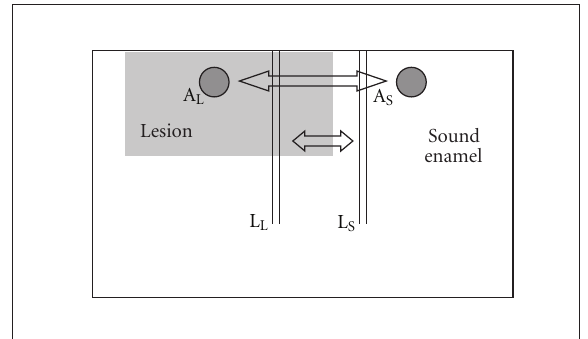
Figure 1: Schematic view of a specimen; the darker area shows the lesion and the white area indicate Sound enamel. Circles of the areas where measurements of XRMA were performed and the parallel vertical lines represent line scans of